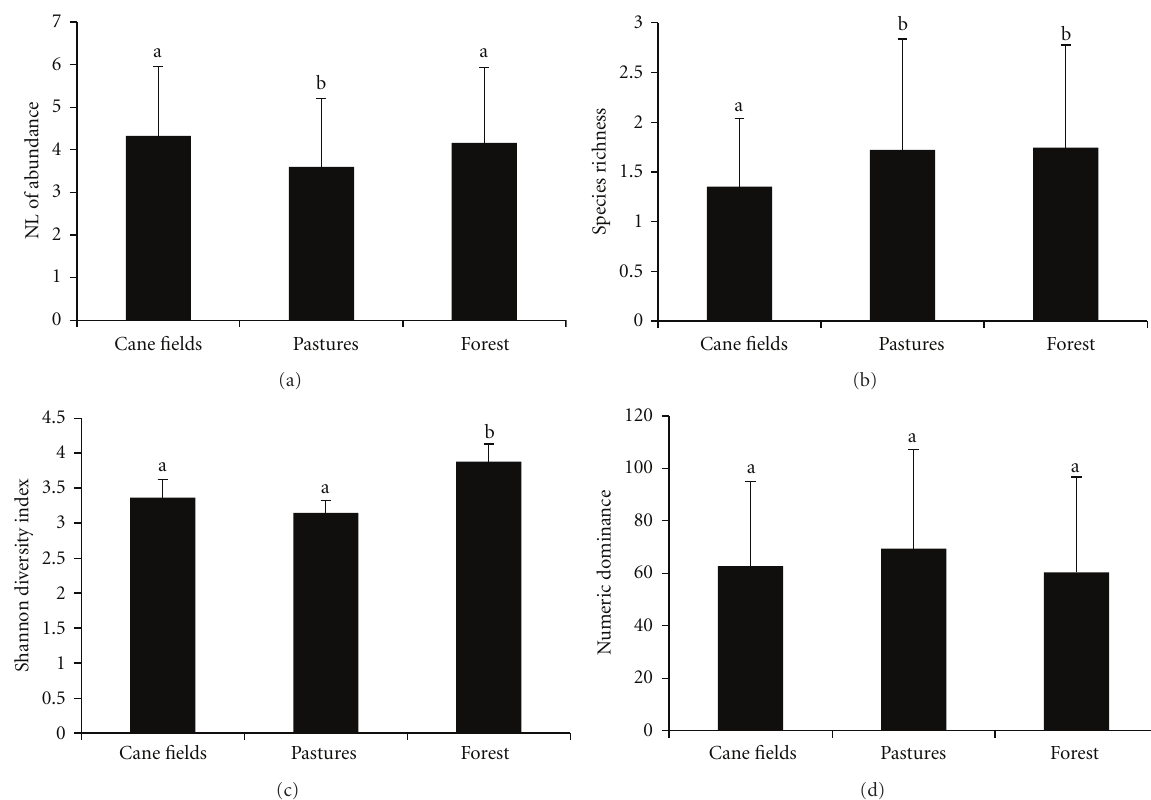
Figure 3: Average values and SD for (a) natural logarithm of the abundance of ants per bait; (b) species richness per bait; (c) shannon diversity index, and (d) numeric dominance of the most abundant species in each habitat. Bars with di ff erent letters are statistically di ff erent.